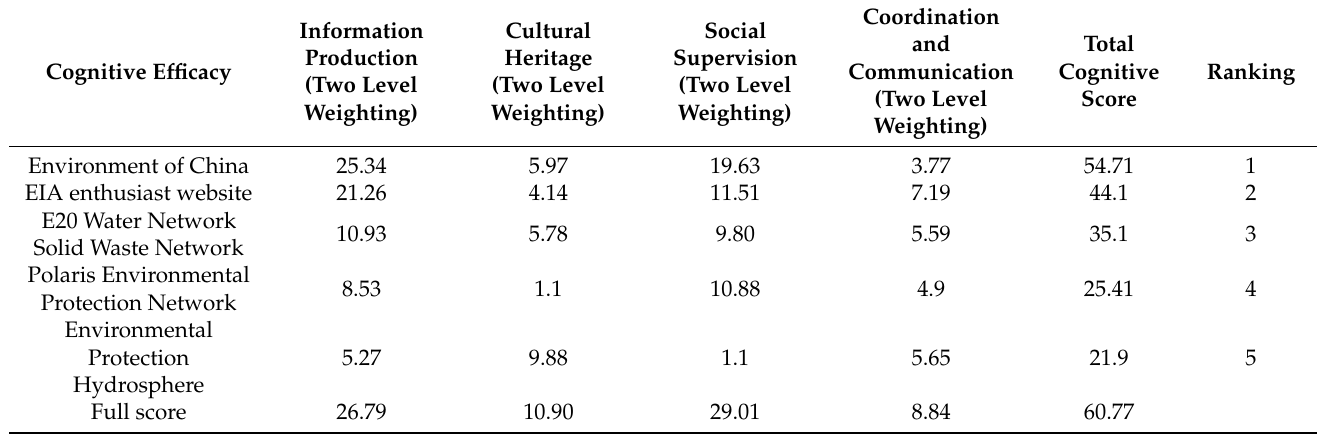
Table 10. Cognitive Efficacy Scores and